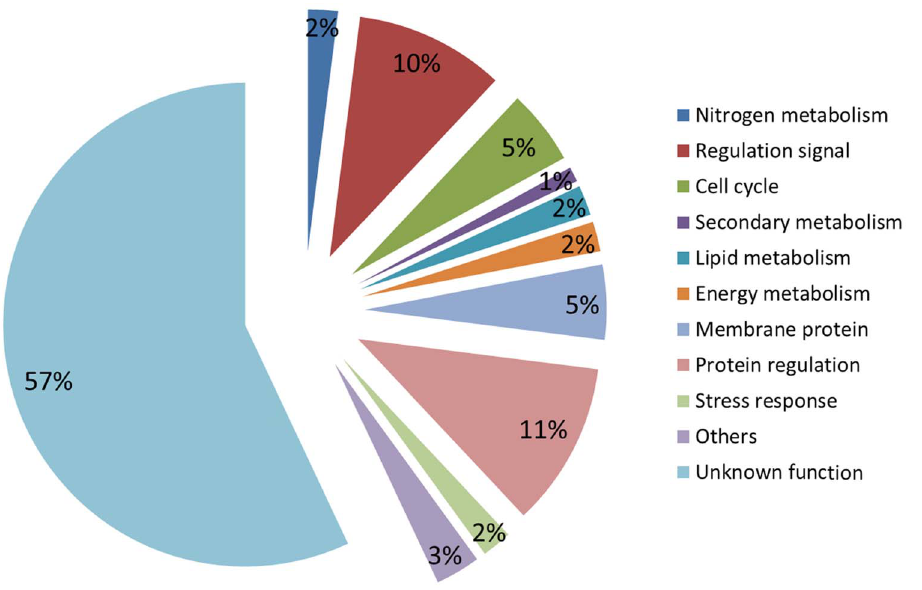
Figure 1. Annotation of Tiso transcriptome. Transcripts were annotated by BLAST in the NCBI nr database. Transcripts were sorted among identified major cell functions from Gene Ontology.